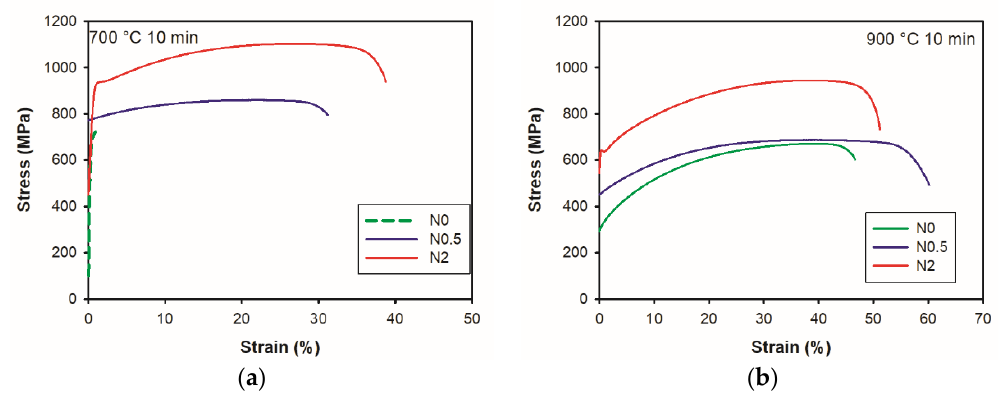
Figure 7. Stress–strain curves of the Fe 40-x Mn 40 Cr 10 Co 10 N x alloys after cold rolling and annealing at 700 °C ( a ) and 900 °C ( b ) obtained during tensile testing at room temperature (293 K). Table 4. Room temperature mechanical properties of the Fe 40-x Mn 40 Cr 10 Co 10 N x alloys after